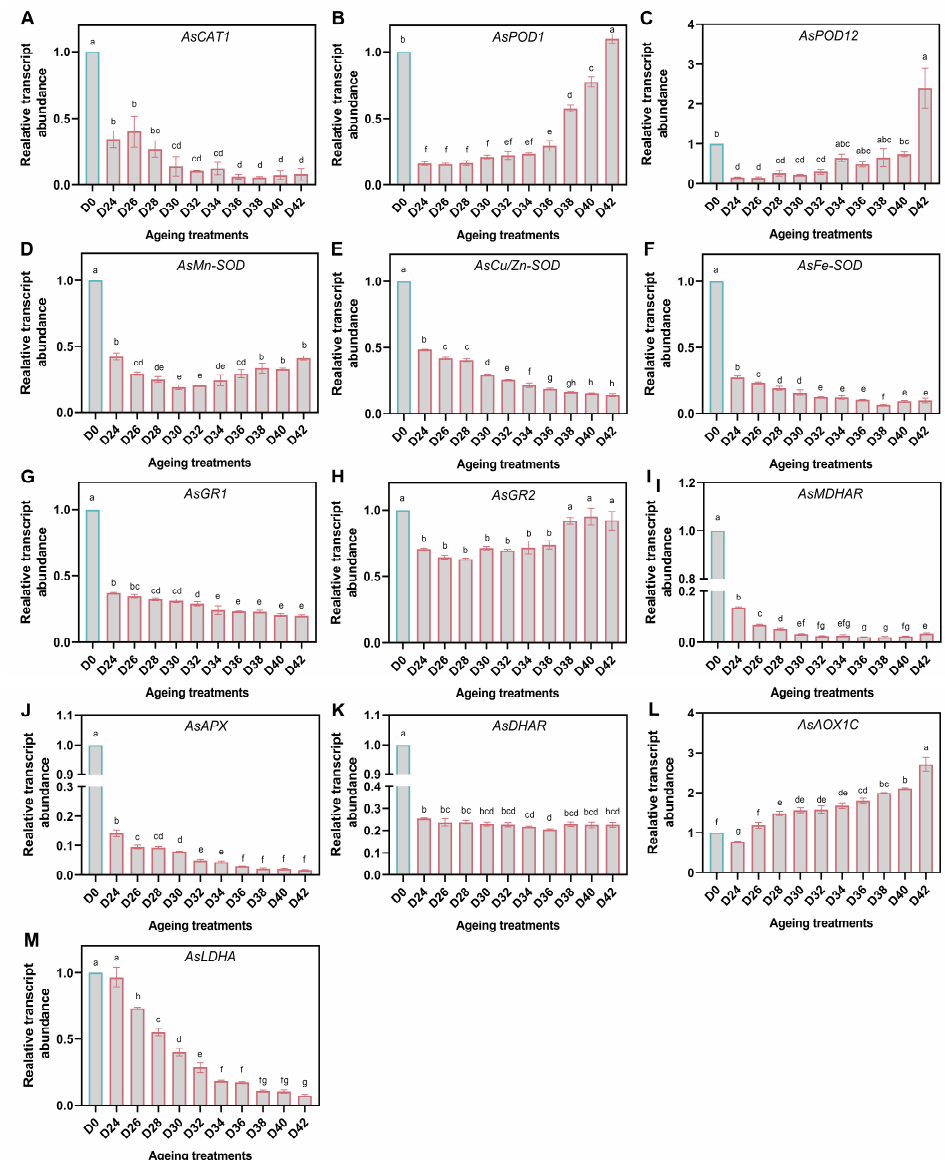
Figure 7. Relative expression levels of genes associated with the ROS scavenging enzymes ( A – K ), alternative respiratory ( L ), and anaerobic glycolysis ( M ) in oat seeds. The letters represent statistical significance among the treatments and the vertical bars represent the ± SEM at p < 0.05 level for three replicates. The mean values sharing same letters, obtained from Duncan test, are not significantly different.